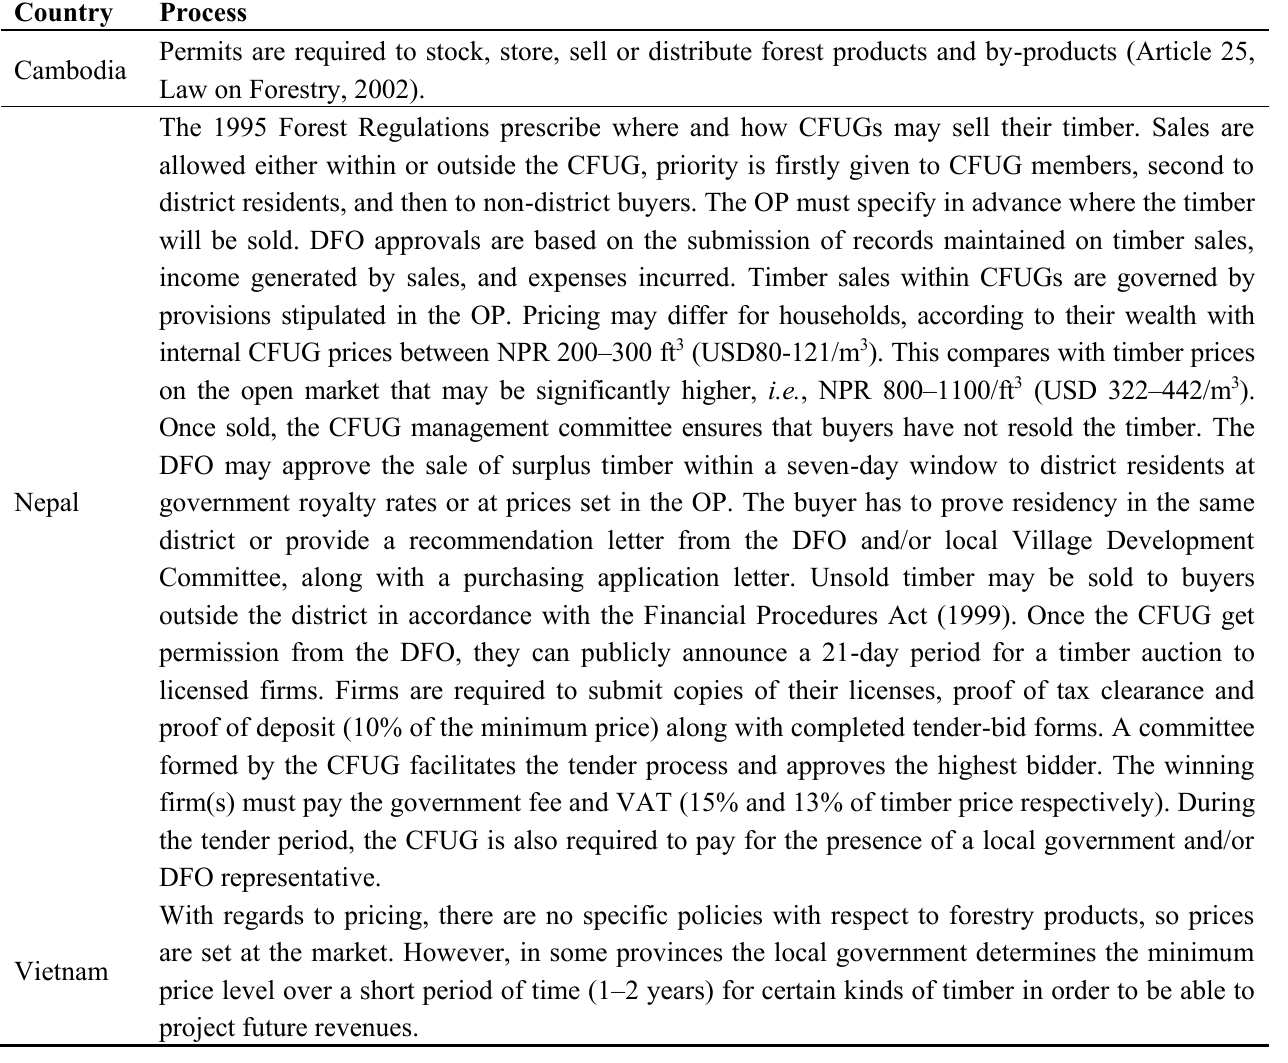
Table 7. Details of requirements for selling timber from community forests in each country